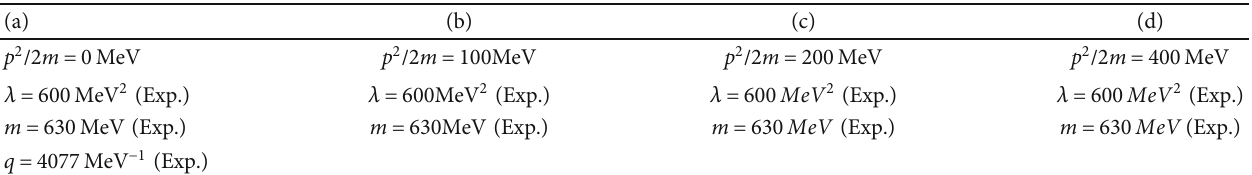
Figure 2: The curves (a) – (d) represent cut o ff graphics of Figure 1 for the ground state c (cid:1) c meson with varying of the kinetic energy. Table 1: The experimental values for linear con fi nement λ , reduced mass m , and maximum relative distance q for c (cid:1) c meson [4,